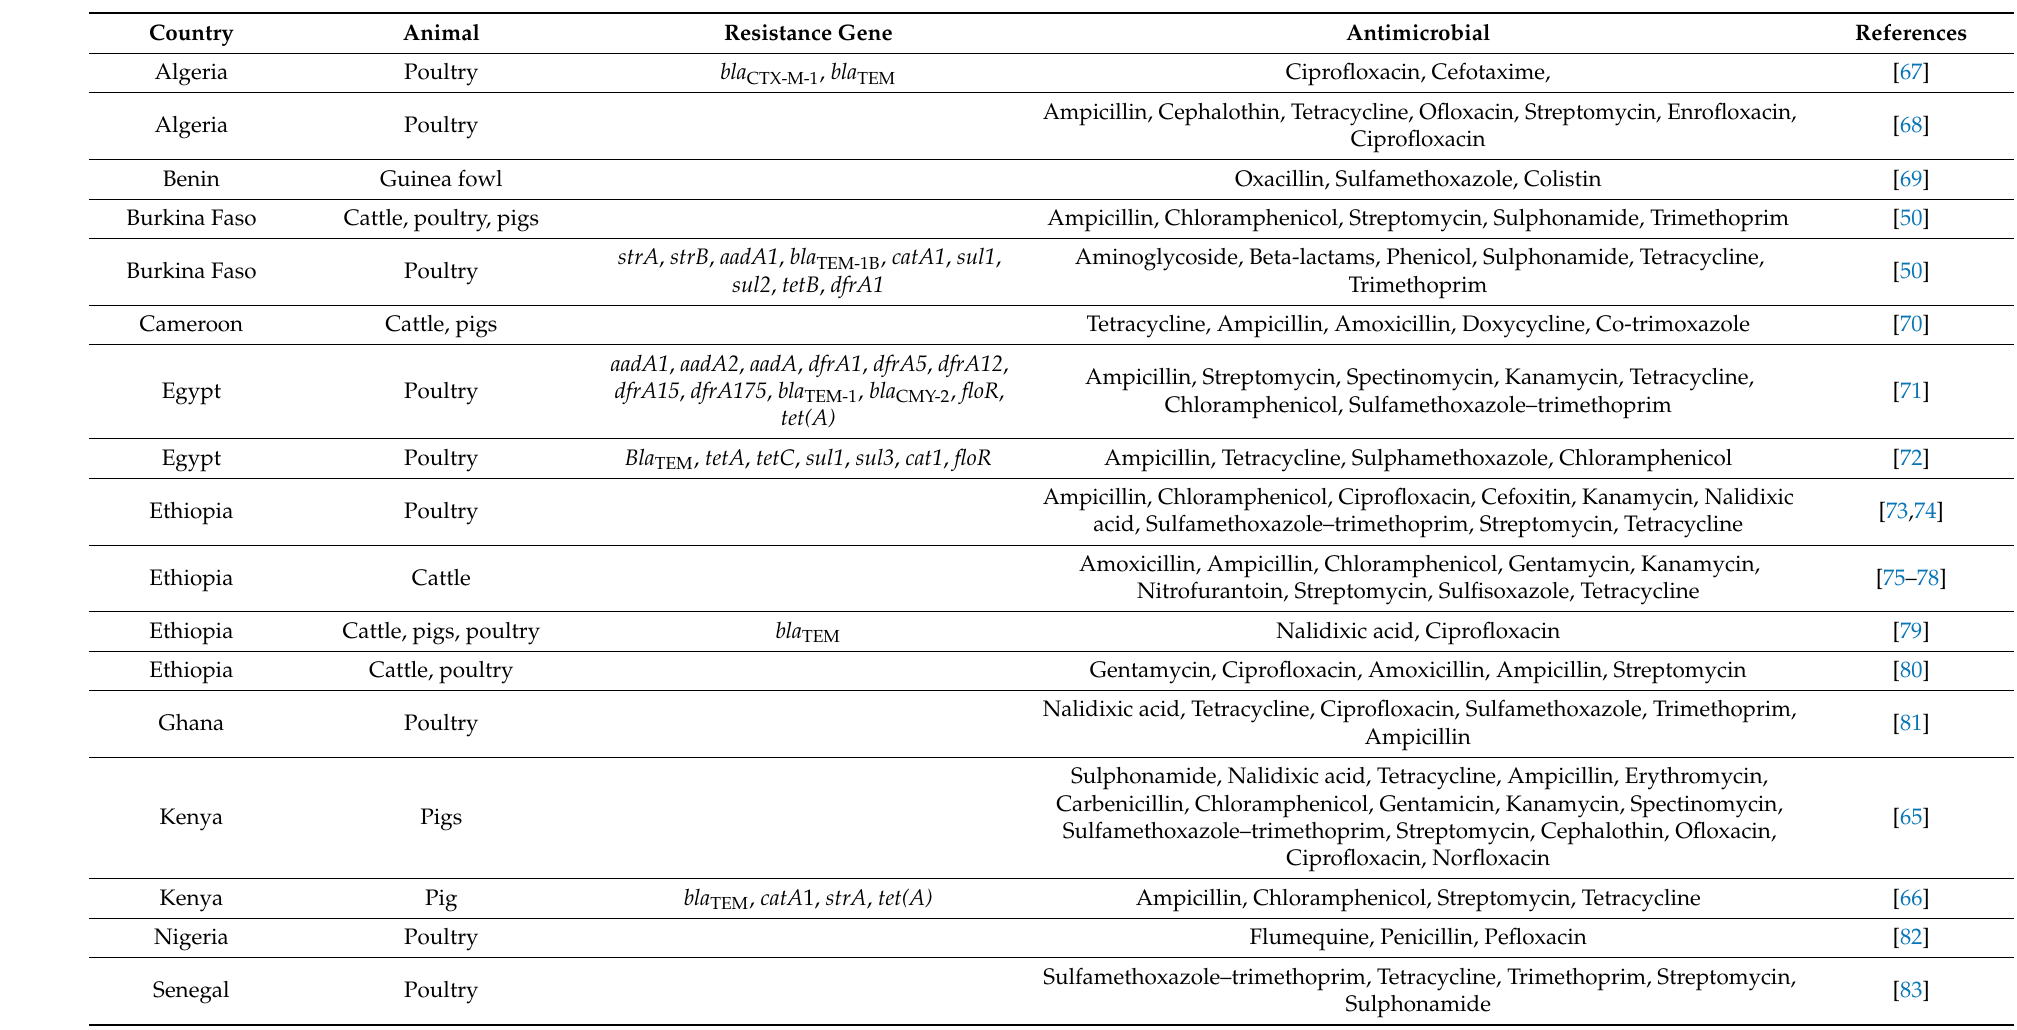
Table 2. Resistance patterns of Salmonella species by animal species and